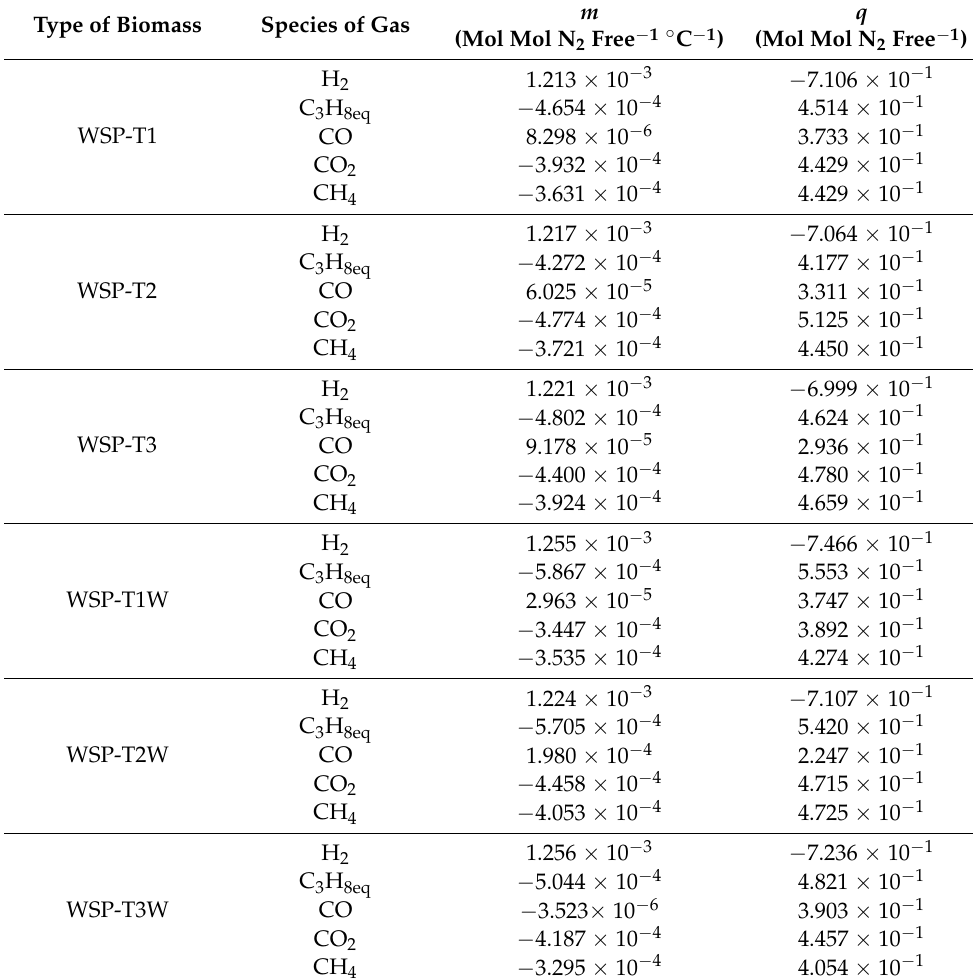
Table 4. Slopes ( m , Equation (7)) and y-axis intercepts ( q , Equation (7)) of the regression straight lines of Y p (Equation (5), i = H 2 , CO, CO 2 , CH 4 , and C 3 H 8,eq. ) for torrefied and torrefied-washed pellets. i , out